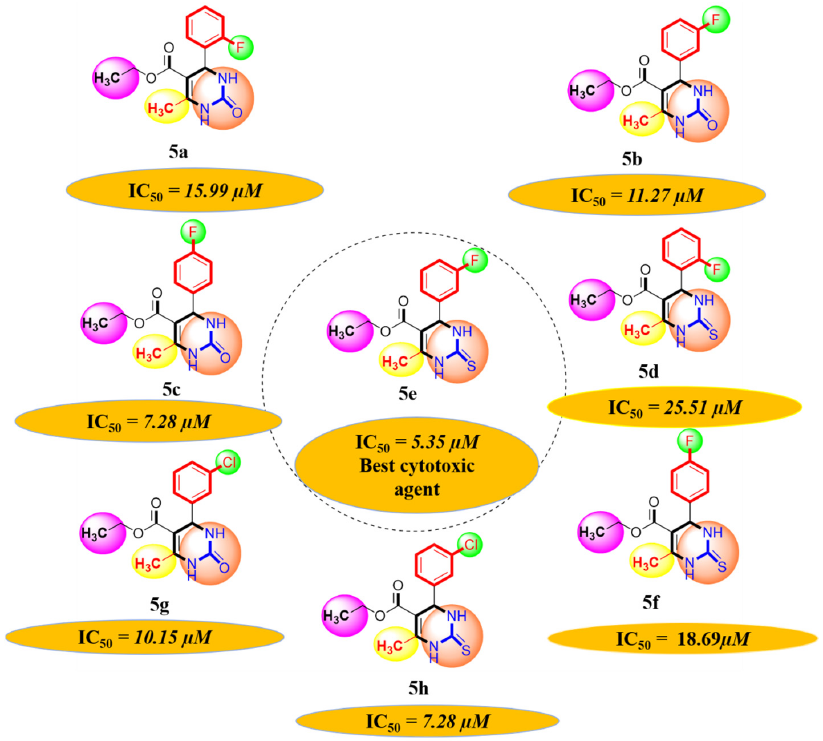
Figure 9. Diagrammatic relationship of target molecules ( 5a – h ) for their structure-activity relationship as anti-cancer agents.